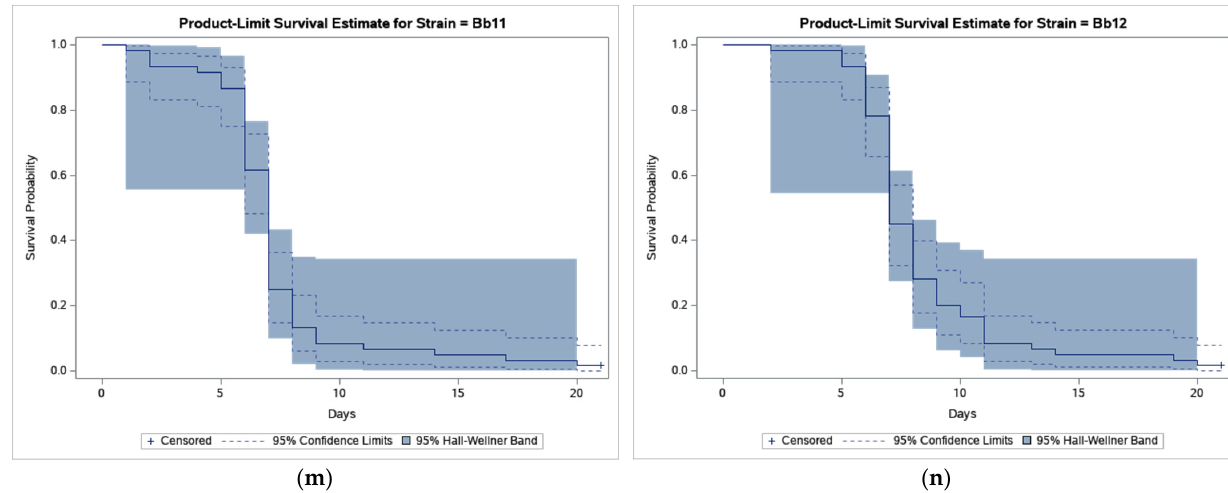
Figure 1. Product-limit survival estimates for Leptinotarsa decemlineata adults treated by Beauveria bassiana or distilled water with 95% confidence limits (dashed lines) and 95% Hall-Wellner bands. ( a ) Control; ( b ) Strain GHA; ( c ) Strain Bb1; ( d ) Strain Bb2; ( e ) Strain Bb3; ( f ) Strain Bb4; ( g ) Strain Bb5; ( h ) Strain Bb6; ( i ) Strain Bb7; ( j ) Strain Bb8; ( k ) Strain Bb9; ( l ) Strain Bb10; ( m ) Strain Bb11; and ( n ) Strain Bb12. Table 2. Corrected mortality, mean survival time ( ± SE), and median lethal time (LT 50 ) of Leptinotarsa decemlineata adults treated by suspensions of native strains of Beauveria bassiana .